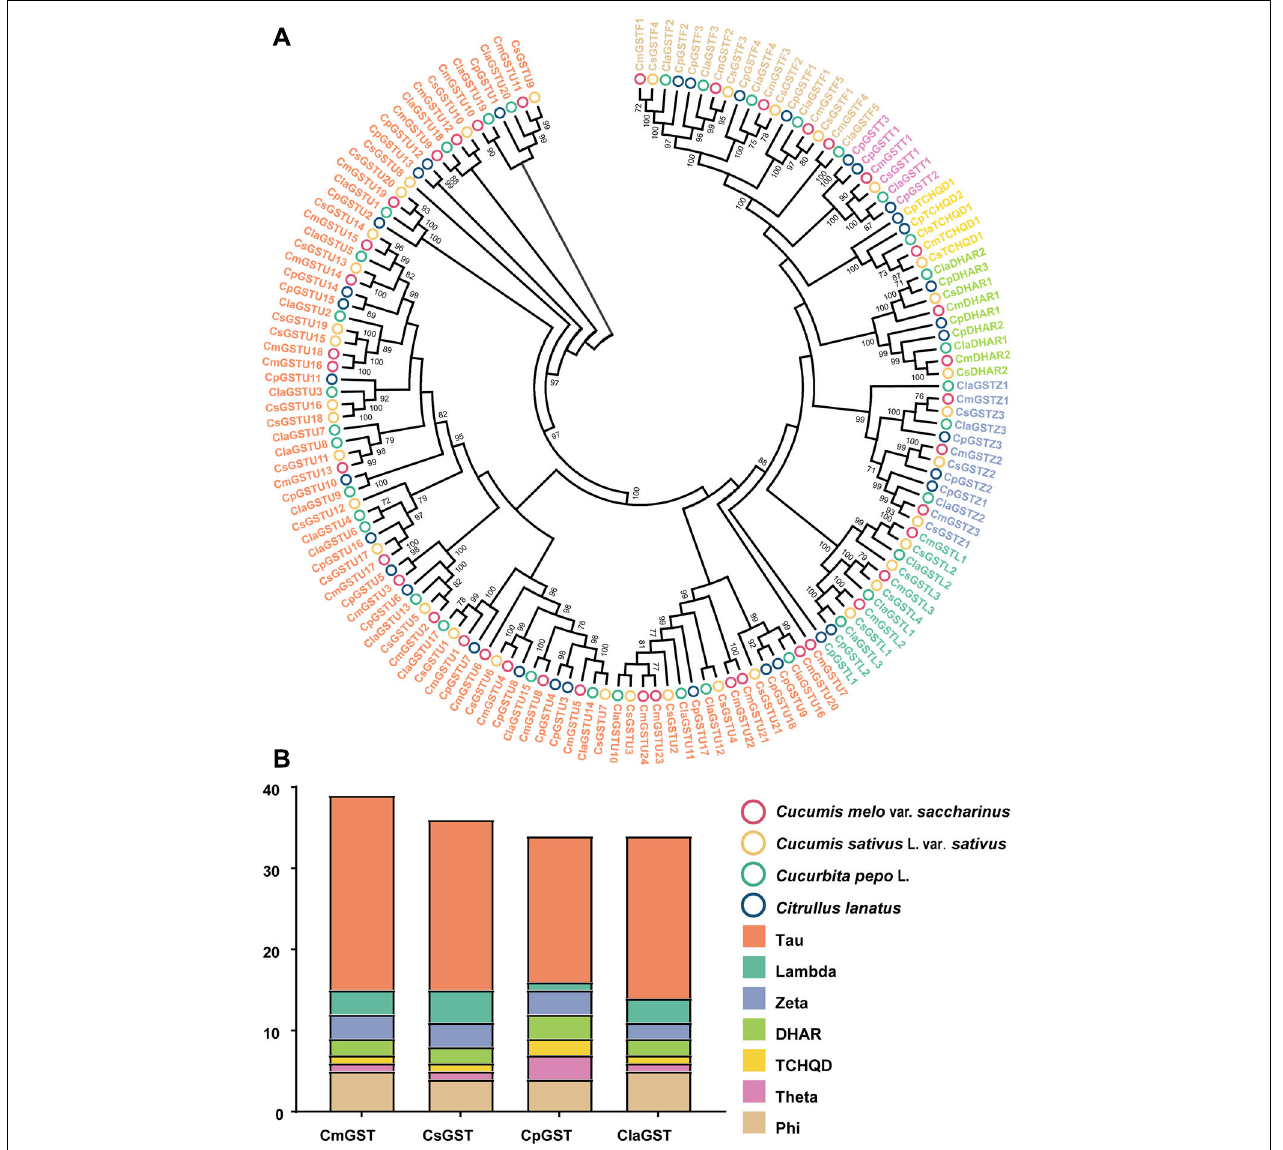
FIGURE 1 | Phylogenetic analysis of GSTs from Hami melon, cucumber, zucchini squash, and watermelon. (A) A total of 145 GST proteins were divided into seven major subfamilies. (B) Comparison of GST members from Hami melon, cucumber, zucchini squash, and watermelon.